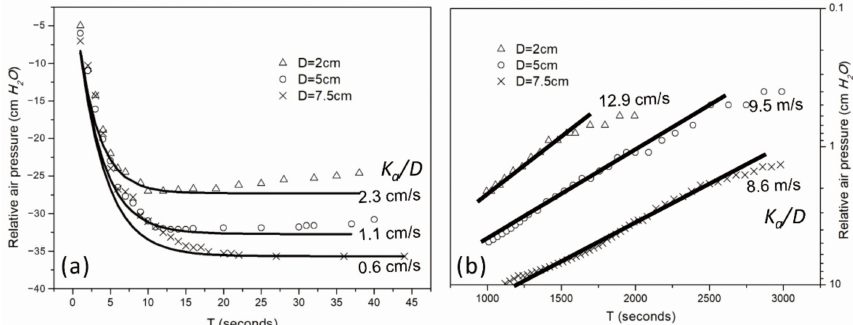
Figure 6. Comparison of observed air pressure and the approximate analytical solutions in the drainage experiments. ( a ) curves derived from Equation (16) for the early period of the experiments. ( b ) curves derived from Equation (25) for the late period of the